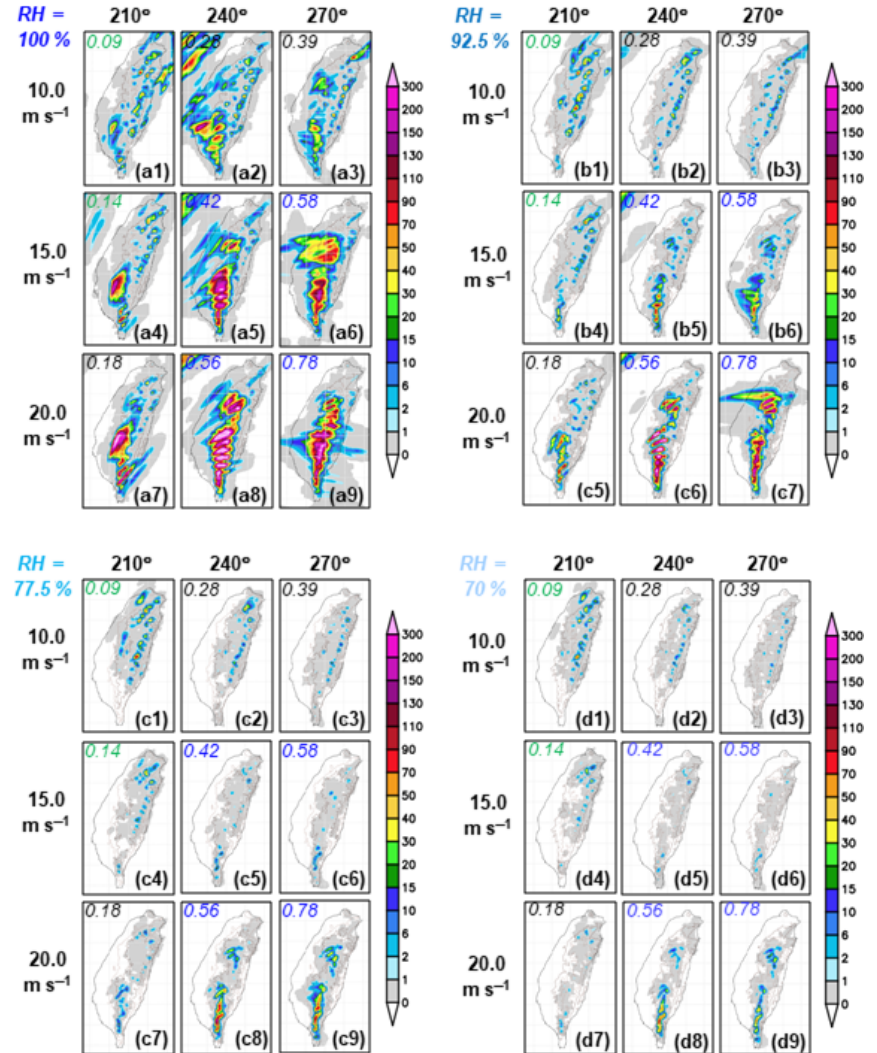
Figure 10. As in Fig. 7 but for the four sets of 3 × 3 experiments of different near-surface RH values of (a) 100%, (b) 92.5%, (c) 77.5%, and (d) 70%. The wind direction (210, 240, or 270 ◦ ) and speed (10, 15, or 20ms − 1 ), as well as the value of Fr w , are all